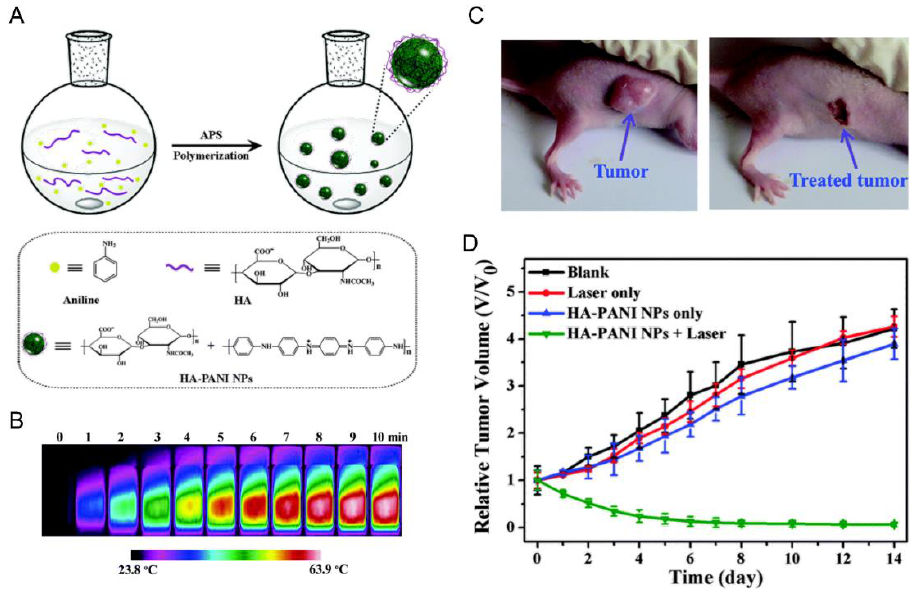
Figure 4. ( A ) Schematic illustration of the synthesis of HA-poly(aniline) (HA-PANI) nanoparticles. ( B ) Photothermal images of solution 100 mg / mL of HA-PANI in water upon exposure to 808 nm laser (2 W / cm 2 ) from 0 to 10 min. ( C ) Representative photographs of the tumor and the treated tumor six days after injection of HA-PANI solutions and irradiation at 808 nm and 0.64 W / cm 2 . ( D ) Tumor growth rates of groups after di ff erent treatment. A saline solution of HA–PANI was injected into the tumor site and exposed to 808 nm laser ( n = 3). Mice with no injection of HA–PANI s (laser only, n = 3) or without 808 nm laser exposure (HA–PANI only, n = 3); blank group with neither injection of HA–PANI nor 808 nm laser exposure (n = 3). The results are expressed as the mean ± SD (n = 3). Adapted with permission from [10]. Copyright 2019, Royal Society of Chemistry.